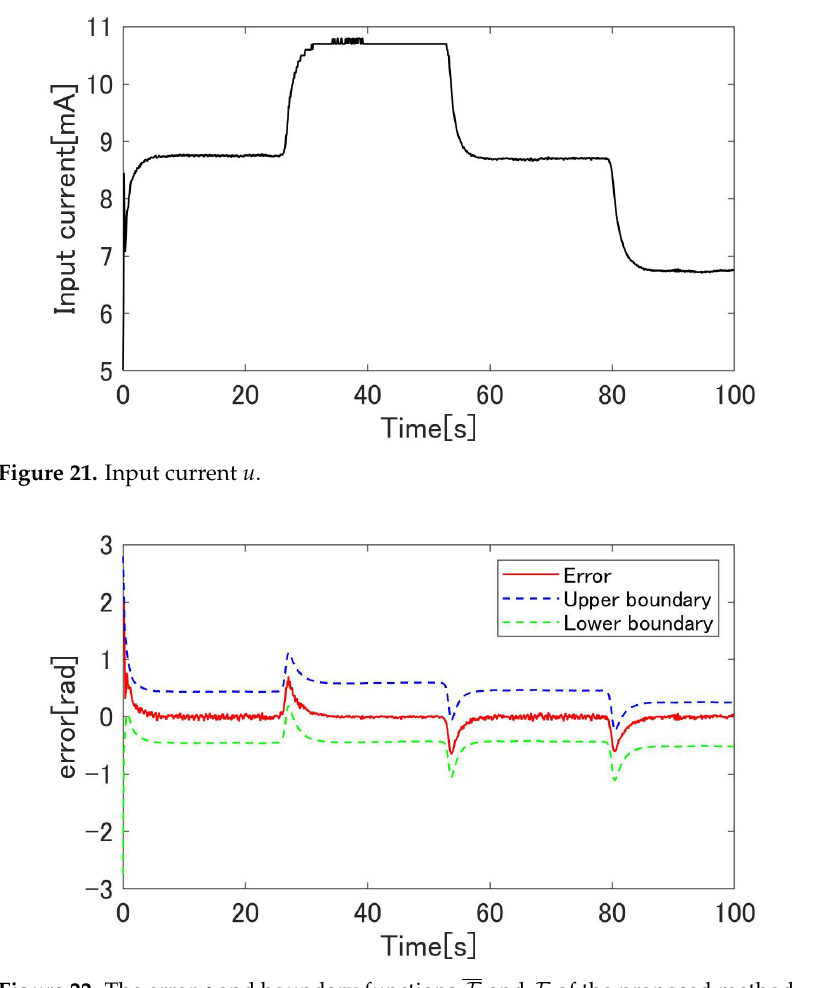
Figure 22. The error e and boundary functions F and F of the proposed method.